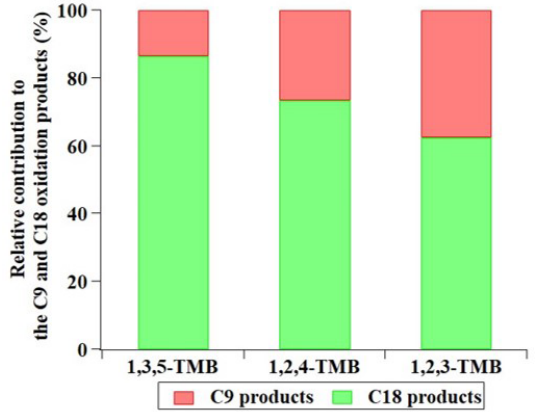
Figure 5. Relative contribution of C 9 and C 18 products formed from TMB oxidation experiments, as measured by the nitrate CI- APi-TOF. The relative intensity has been corrected with the relative transmission efficiency.